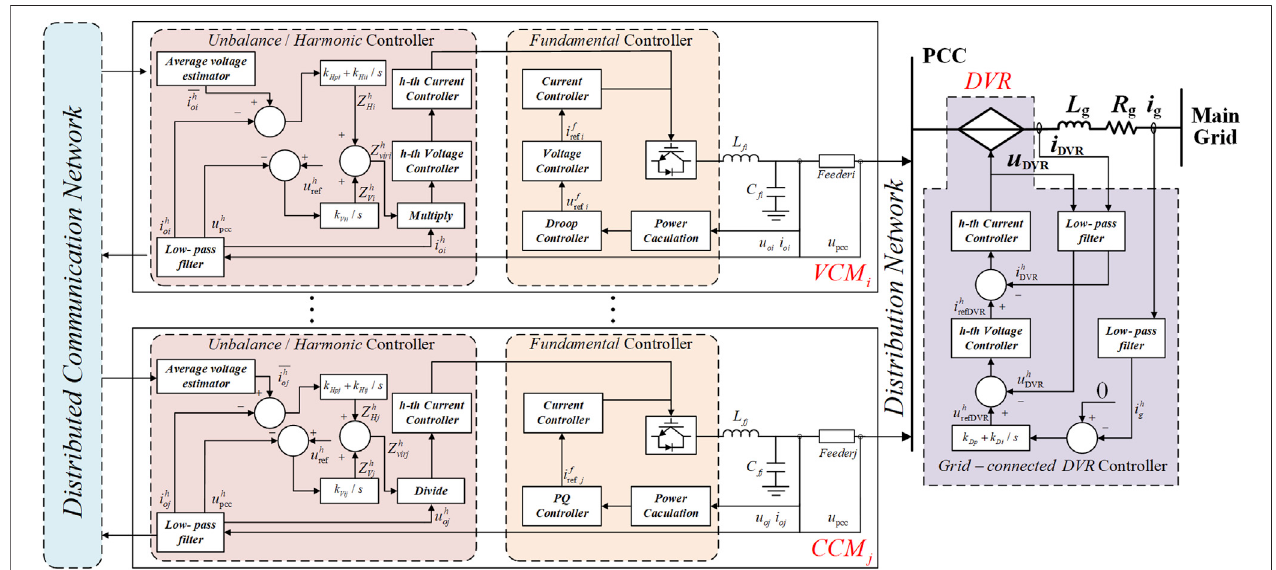
FIGURE 5 | Block diagram of the proposed control architecture.